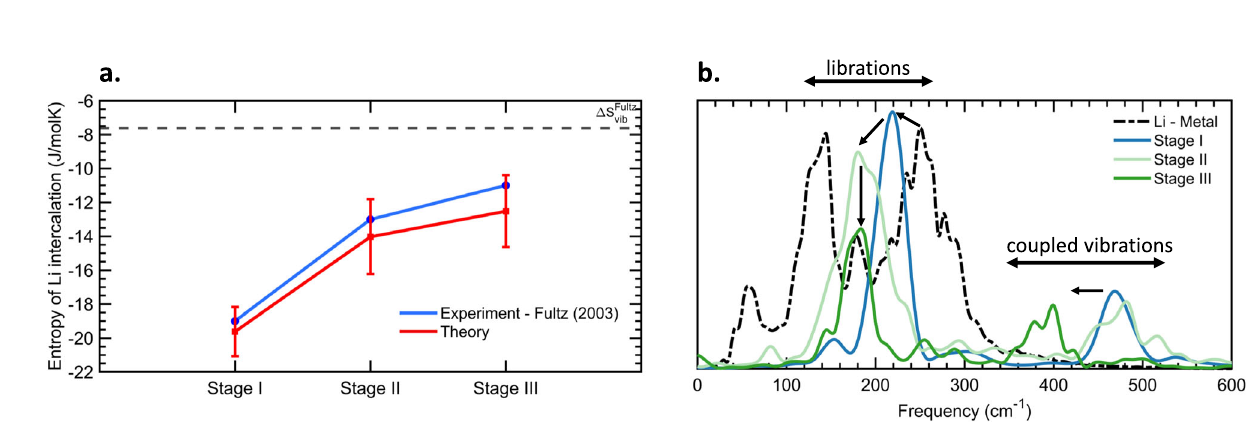
the graphite cage ( left inset ), b LiC 12 and c LiC 18 , and d graphite from charge pud- dling. Source data are provided as a Source Data fi le.